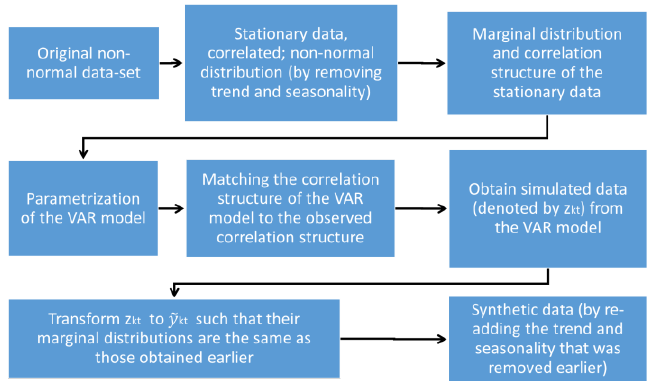
Figure 1. Schematic representation of the wave data generation methodology.